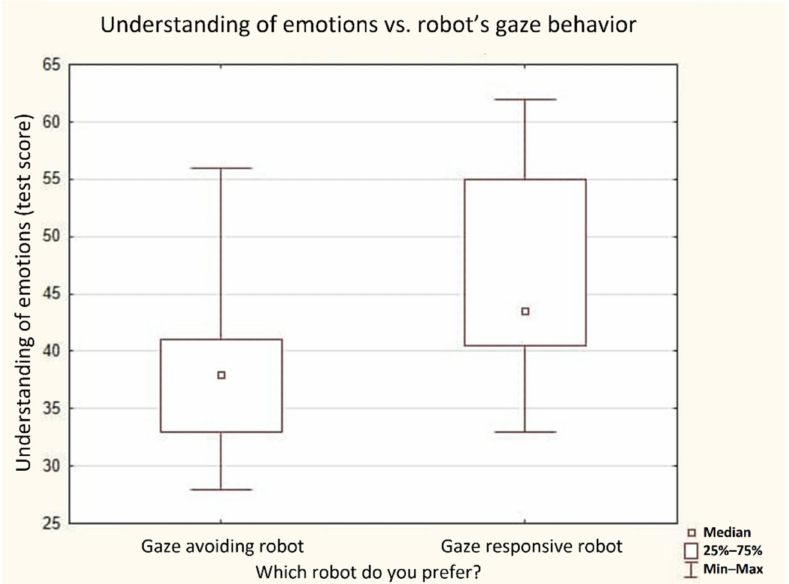
Figure 6. Level of emotional intelligence in our subjects vs. their preferences of the robots’ social gaze